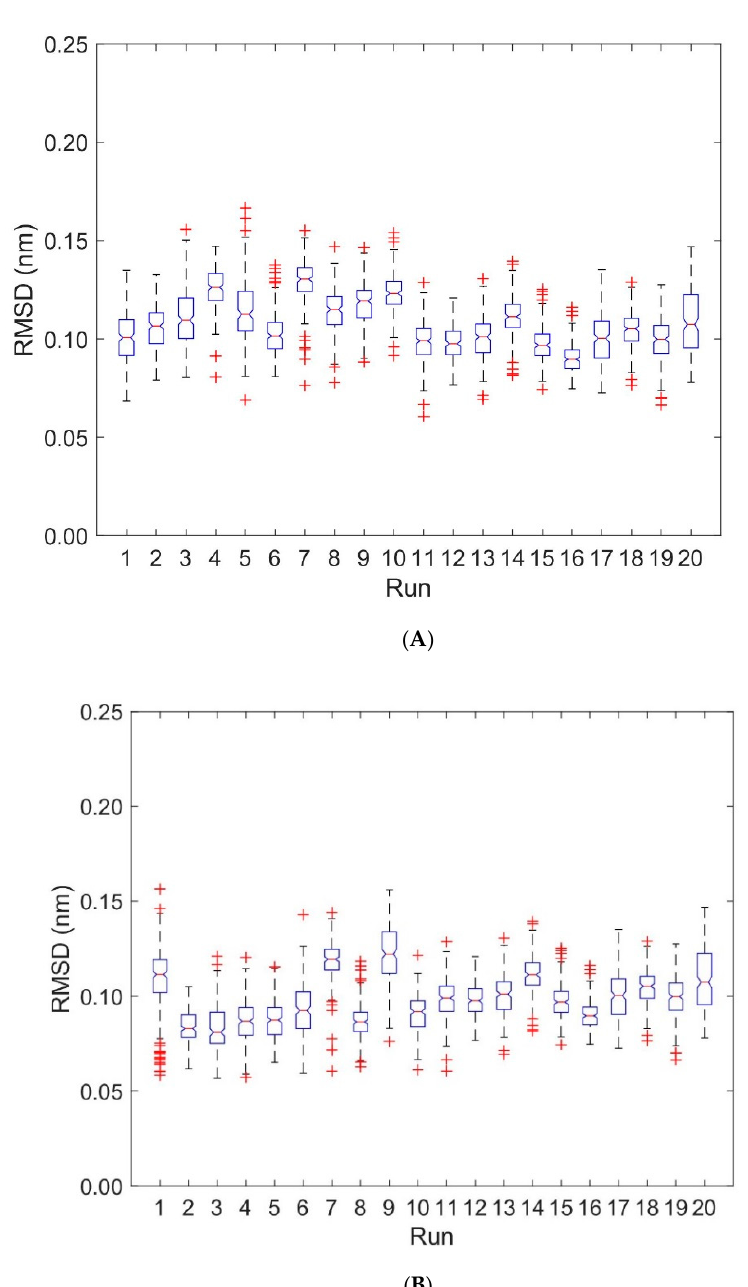
Figure 4. Boxplots of RMSD for TCR V α and TCR V β . RMSD-values are computed for every 0.2 ns with respect to the first frame of each trajectory. Run numbers 1 to 10 correspond to unbound states, 11 to 20 to bound states. ( A ) RMSD for TCR V α domain. ( B ) RMSD for TCR V β domain. Table 1. RMSD (mean ± SD) in nm for various domains of the unbound molecules TCR and pMHC as calculated from 20 (10 for free TCR and 10 for free MHC) 40 ns MD runs (1–10) and from two (free TCR and free MHC) 400 ns MD runs (11).